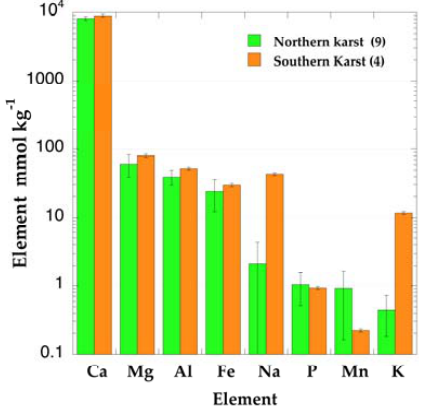
Figure 2. Average elemental composition of karst rocks from northern and southern sites in Puerto Rico.